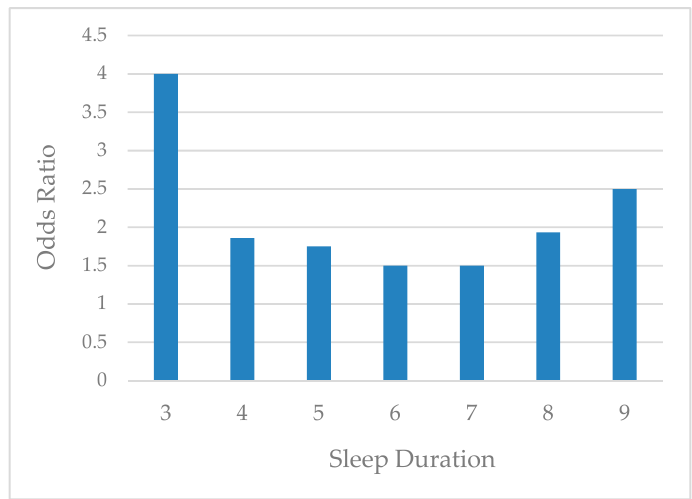
Figure 1. Odds Ratio of the MetS risk by sleep duration. Odds ratio of the MetS risk was plotted against sleep duration in all subjects.